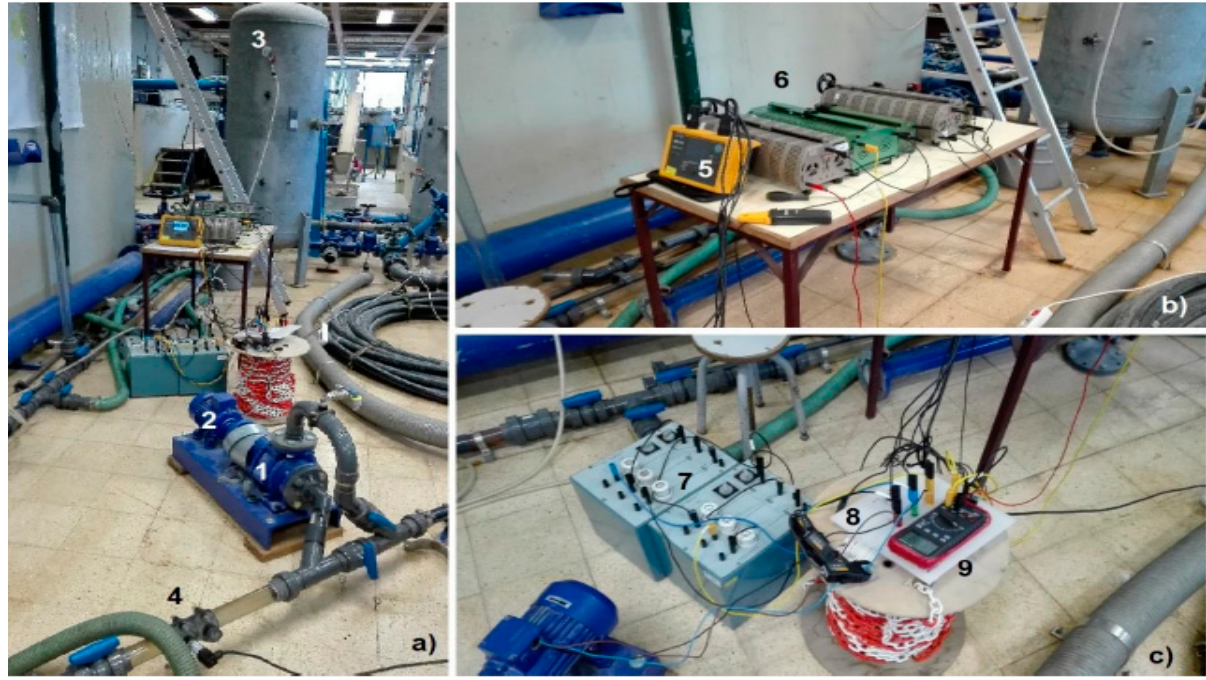
Figure 18. Installation assembled at the Hydraulic Laboratory at IST: ( a ) 1—PAT, 2—induction generator, 3—compressed air reservoir, 4—pressure sensors; ( b ) 5—digital multimeter FLUKE, 6—three-phase wye resistive load; ( c ) 7—bank of capacitors, 8—switch, 9—voltmeter.